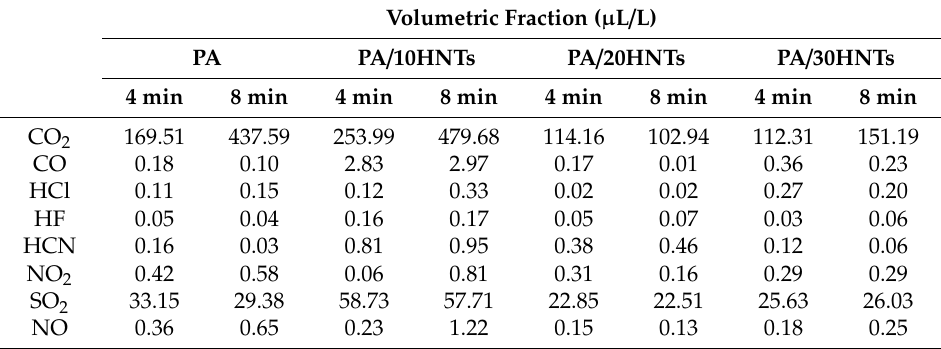
Table 6. Volumetric fraction of the combustion gases.